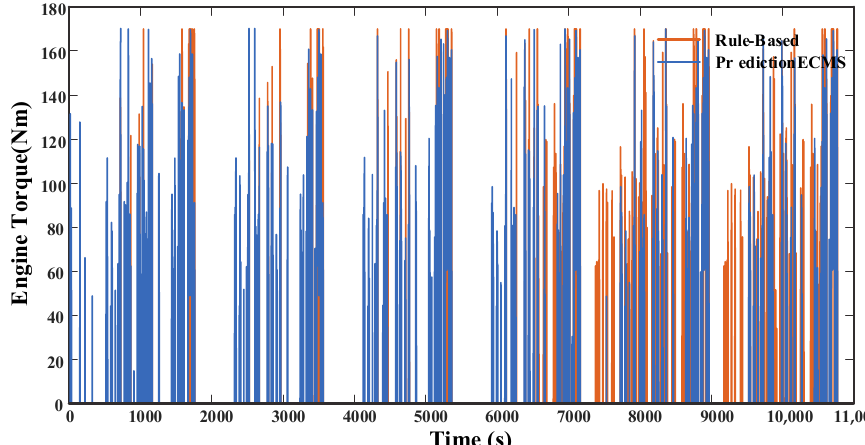
Figure 20. Engine output torque under different strategies.